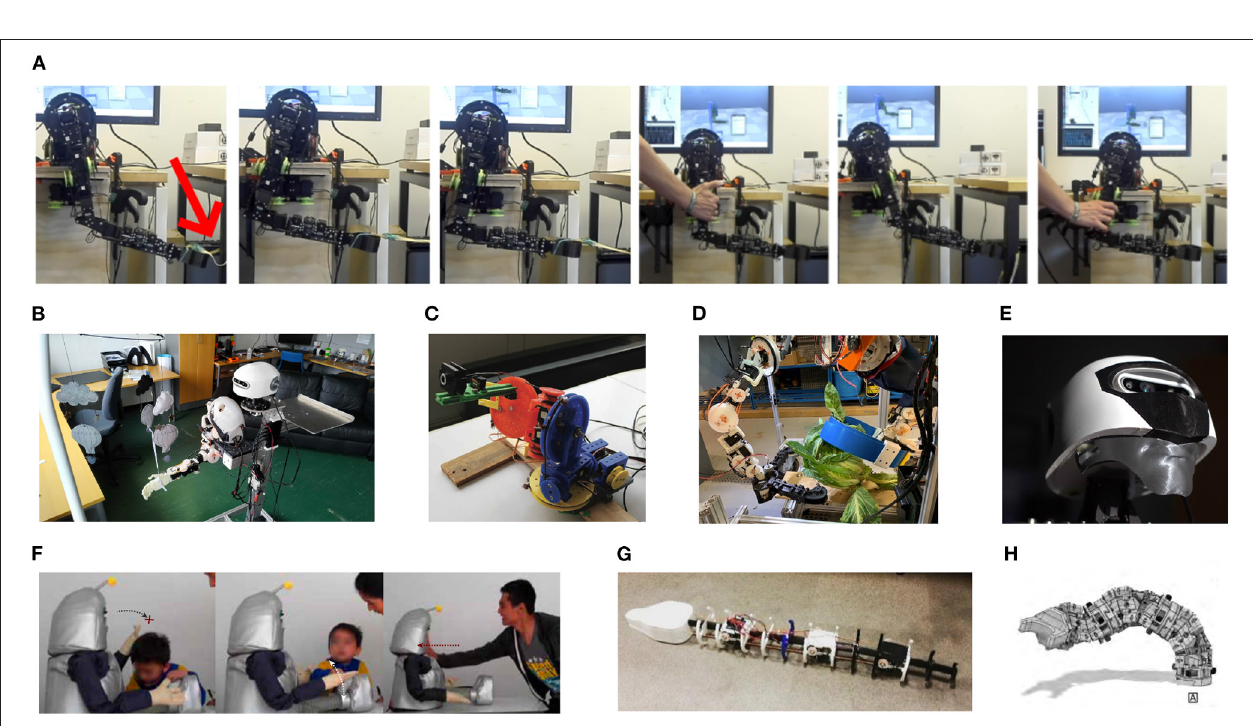
FIGURE 13 | Response data corresponding to the impacts shown in Figure 12 . In (A) the shoulder yaw joint can be seen to be forced through a large portion of its range of movement (“soft” range limited between –29.8 and 59.6 ◦ ). The response is both passive, mainly through the elastic tendons, and active, as seen in the collision response by the servos of the joint. An accelerometer was mounted on the lower arm, and saturated at 27.8 g of acceleration during the first impact, as is seen in (B) . The arm was teleoperated normally from 2.5 seconds onwards.